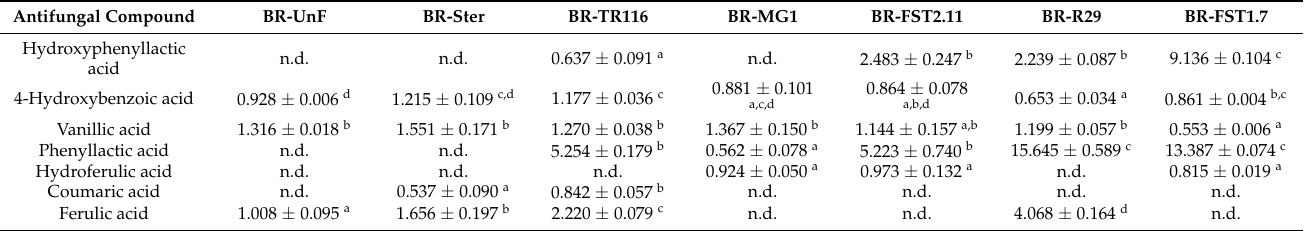
Table 6. Analysis of the antifungal compounds present in BR ingredients in g/100 g of dry mat- ter. BR-UnF and BR-Ster represent control ingredients: unfermented barley rootlets and sterile, freeze-dried barley rootlets, respectively. BR-TR116, BR-MG1, BR-FST2.11, BR-R29, and BR-FST1.7 illustrate fermented rootlet ingredients that were fermented using L. citreum TR116, W. cibaria MG1, L. amylovorus FST2.11, L. reuteri R29, and L. plantarum FST1.7, respectively. Results are represented as means ± standard deviation. No significant differences were found between samples that shared the same subscript letter in the same row ( p <